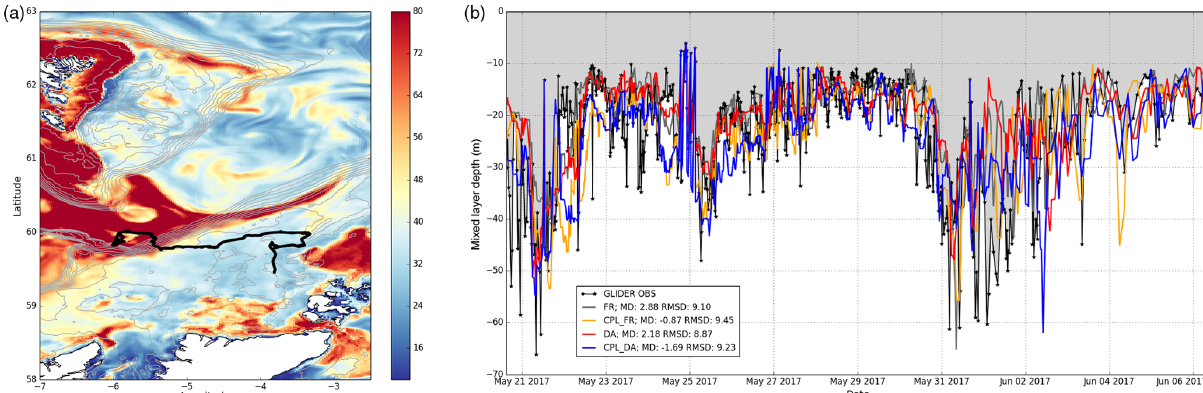
Figure 10. (a) Daily mean MLD on 1 June 2017 simulated by FR for a section of the model domain to the north of Scotland. Contours mark the model bathymetry in 50m intervals and the thick black line marks the glider trajectory. (b) MLD calculated from observed and model profiles following the glider trajectory over the observation period. Grey shading indicates the mixed layer according to glider observations.